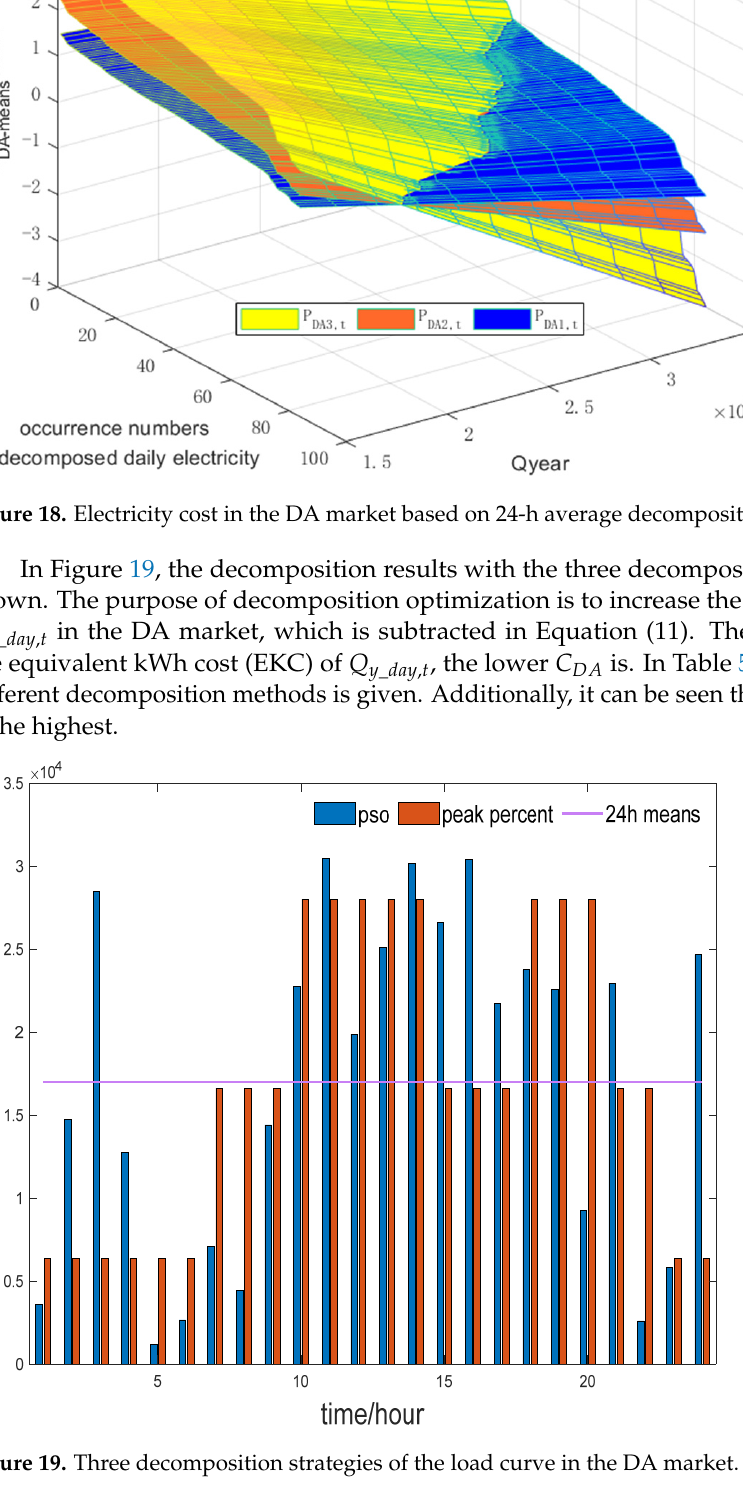
Table 5. Average kilowatt-hour price based on three DA prices.